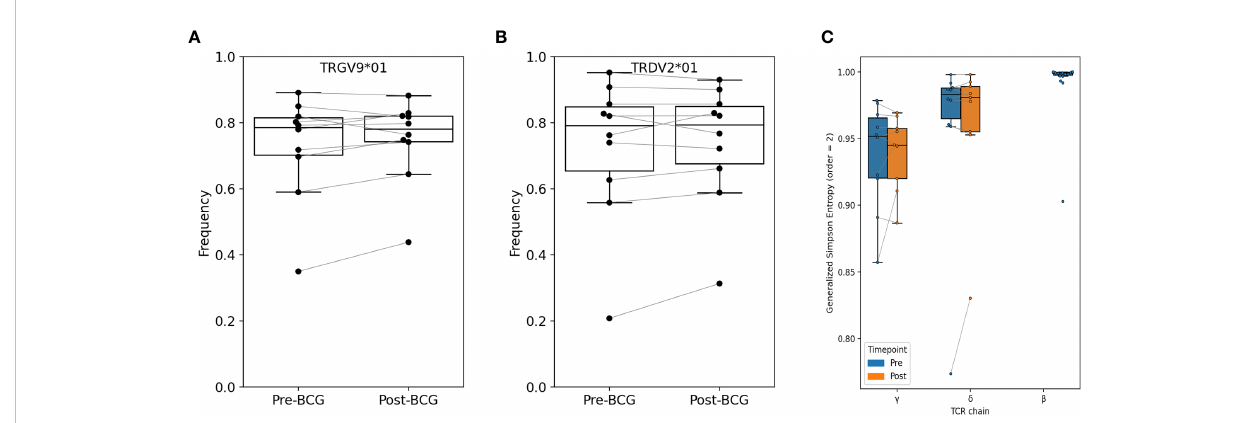
FIGURE 2 Relative abundance of TRGV9 and TRDV2 genes and diversity among bulk sequenced T cells. Frequency of (A) TRGV9 and (B) TRDV2 genes are shown before and after BCG vaccination; no signi fi cant differences were found (paired signed-rank test, FWER-p > 0.05 and FDR-q > 0.05). Additional V-gene frequency comparisons are provided in Supplementary Material. (C) Diversity was computed as Generalized Simpson ’ s Entropy (order = 2, equivalent to Simpson ’ s Diversity Index); the statistic can be interpreted as the probability of drawing two different TCRs at random from the repertoire. Samples were rari fi ed to 30K productive templates for the purpose of computing diversity. One sample (V005-Post-BCG) was excluded for low sequencing depth. Across participants, repertoire entropy was not signi fi cantly altered after BCG vaccination (p >